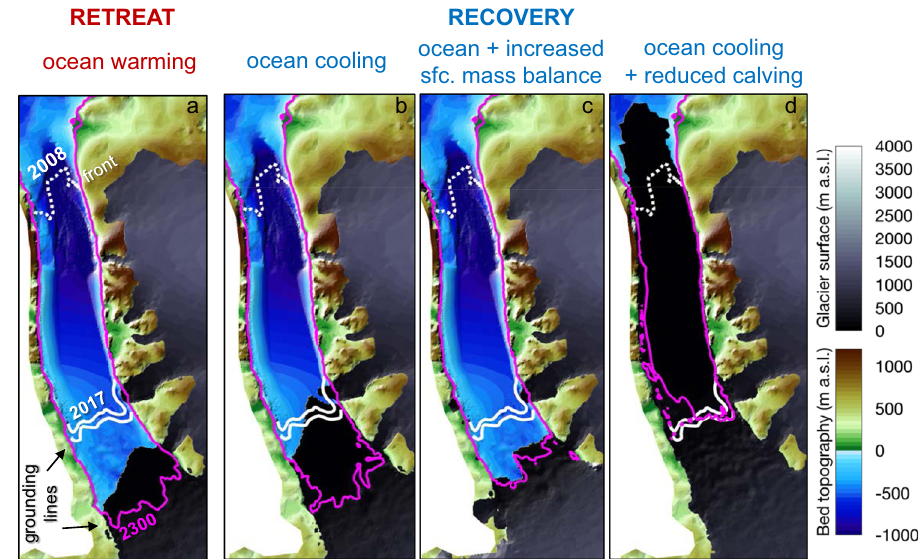
Fig. 3 It is dif fi cult to recover an ice shelf once it has disappeared. a Future retreated 19 state of Petermann Glacier; panels b – d show the evolution of glacier geometry for the forcings compared in Figs. 1 and 2. Only an ocean cooling combined with reduced calving rates, as shown in d , allow Petermann to re-advance to its contemporary state. b ocean cooling and c ocean cooling + increased surface (sfc.) mass balance lead to continued elevated ice discharge (Fig 2c), and thus a sustained high contribution to sea-level rise even in a cool